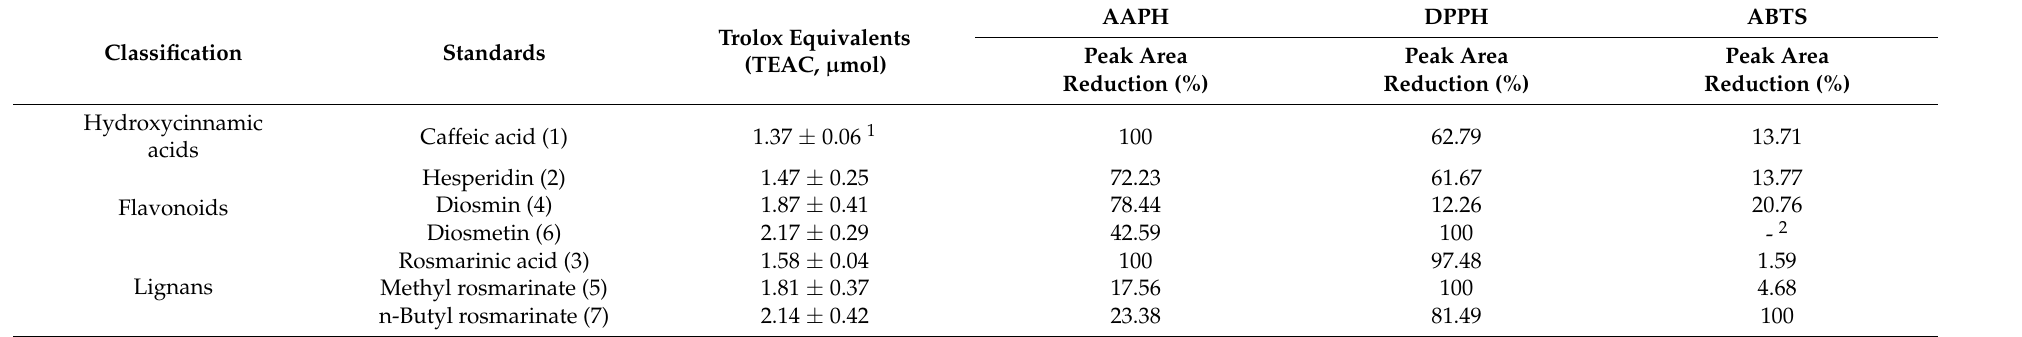
Table 3. Comparison of three offline HPLC methods of DPPH, ABTS, and AAPH of 7 compounds isolated from L. meyenii